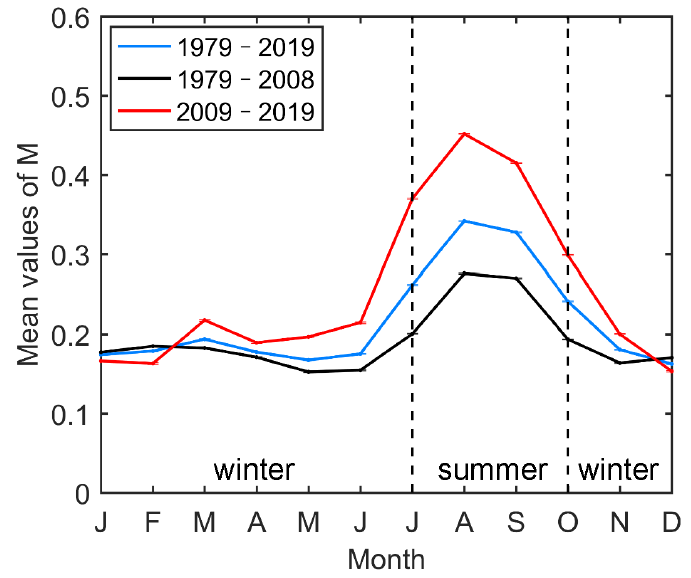
Figure 5. Seasonal variations of M values in 1979 – 2019 (blue line), 1979 – 2008 (black line) and 2009 – 2019 (red line). July, August and September constitute the summer, and the rest are winter.